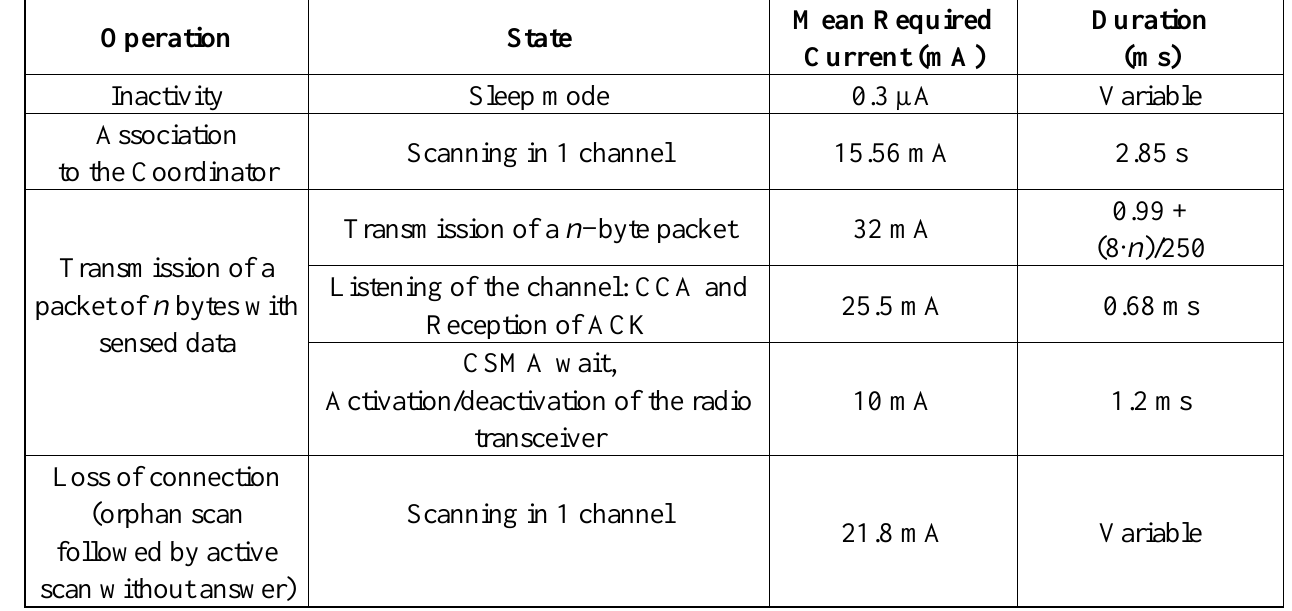
Table 4. Summary of drained current for different 802.15.4/ZigBee operations in the MC1322x